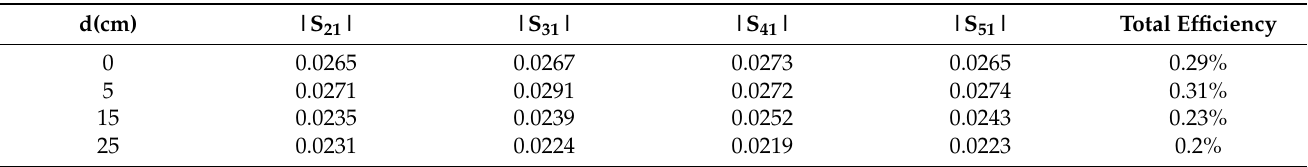
Table 2. The efficiency of conventional multiple receivers WPT system in the different distances of the adjacent Rx